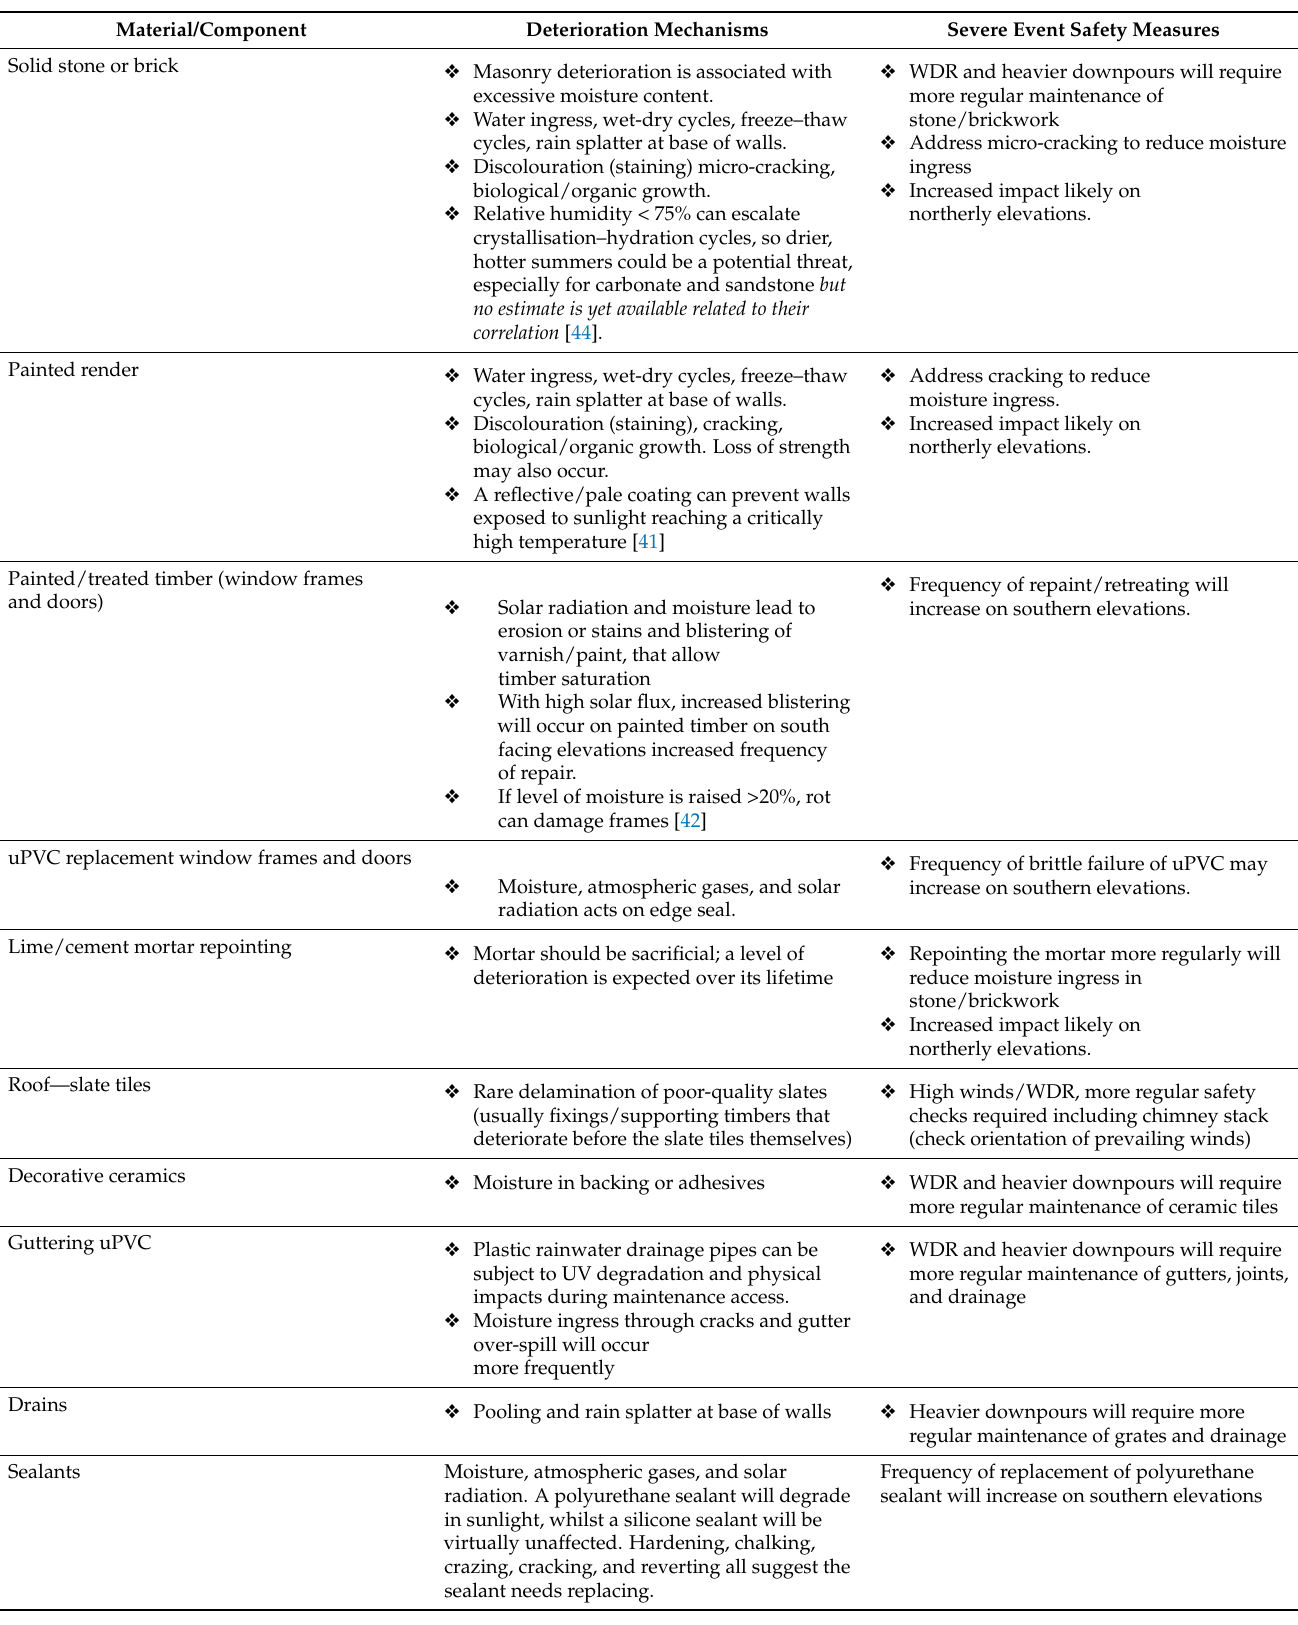
Table 5. Known material and component deterioration mechanisms and severe event safety measures to inform repair, maintenance, and adaptation